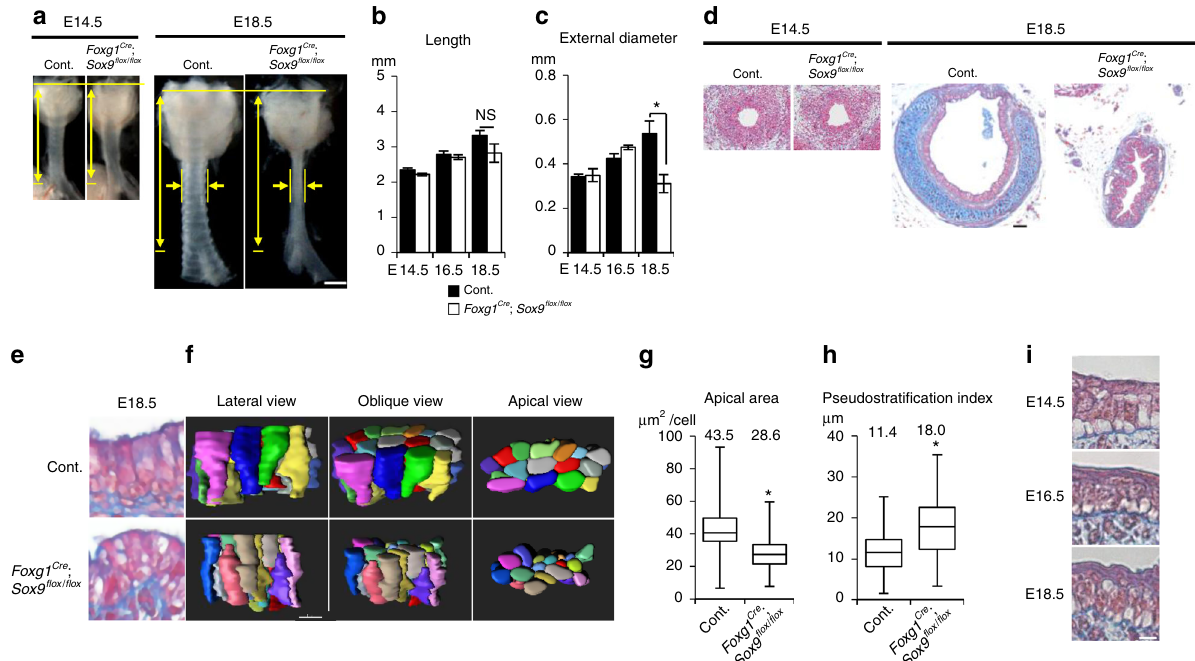
Fig. 6 Cartilage development expands the tracheal but not esophageal diameter and promotes epithelial rearrangement for luminal enlargement. a Gross morphology of Foxg1 Cre ; Sox9 fl ox/ fl ox trachea and littermate control. Yellow arrows indicate length and diameter of the tracheas. Measurement of tracheal tube length ( b ) and external diameter ( c ). (Control; n = 5 – 8, Foxg1 Cre ; Sox9 fl ox/ fl ox ; n = 3 or 4). d Azan staining of transversal sections. e Azan staining of Foxg1 Cre ; Sox9 fl ox/ fl ox trachea epithelium. f Representative 3D reconstructed images of epithelial-cell cluster (20 cells) of Foxg1 Cre ; Sox9 fl ox/ fl ox or littermate control at E18.5. (left, apical view; middle, oblique view; right, lateral view). See also Supplementary Movie 7. g Apical-surface area at E18.5. center line, box limits, and whiskers represent mean, 25 and 75% con fi dence limits, and min and max values, respectively. Numbers represent means. (Control, n = 119, Foxg1 Cre ; Sox9 fl ox/ fl ox , n = 107). h Pseudostrati fi cation index at E18.5. center line, box limits, and whiskers represent mean, 25 and 75% con fi dence limits, and min and max values, respectively. Numbers represent means (Control, n = 130; Foxg1 Cre ; Sox9 fl ox/ fl ox , n = 84). ( i ) Azan staining of developing esophageal epithelium. P values ( ** P < 0.01, * P < 0.05) show the signi fi cance with Student ’ s t test ( b , c , g , h ). NS not signi fi cant. Scale bar = 500 μ